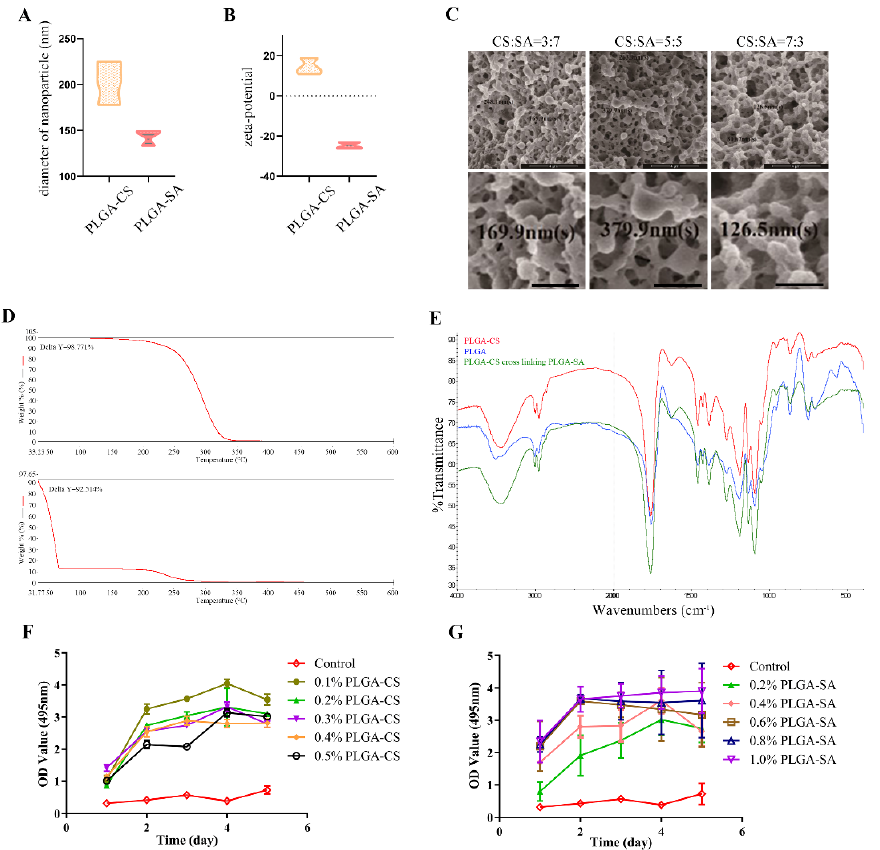
Figure 1. Characterisation of PLGA-microparticles. ( A ) Diameter of microparticles. ( B ) Zeta-potential of microparticles. ( C ) Scanning electron microscopy images of PLGA-CS and PLGA-SA cross-linked microparticles. The black number indicates particles diameter of the cross-linked microparticles. All three cross-linked materials exhibited a loose microporous structure, with a pore diameter between 100 nm and 400 nm. ( D ) TGA curve from PLGA (top), PLGA-CS cross-linking PLGA-SA (bottom) microparticles at temperatures between 33 and 600 °C . ( E ) FTIR spectra of PLGA-CS (red), PLGA (blue), PLGA-CS cross-linking PLGA-SA (green). ( F , G ) CCK8 assay ADSCs proliferation on different concentrations of PLGA-CS and PLGA-SA on five consecutive days.